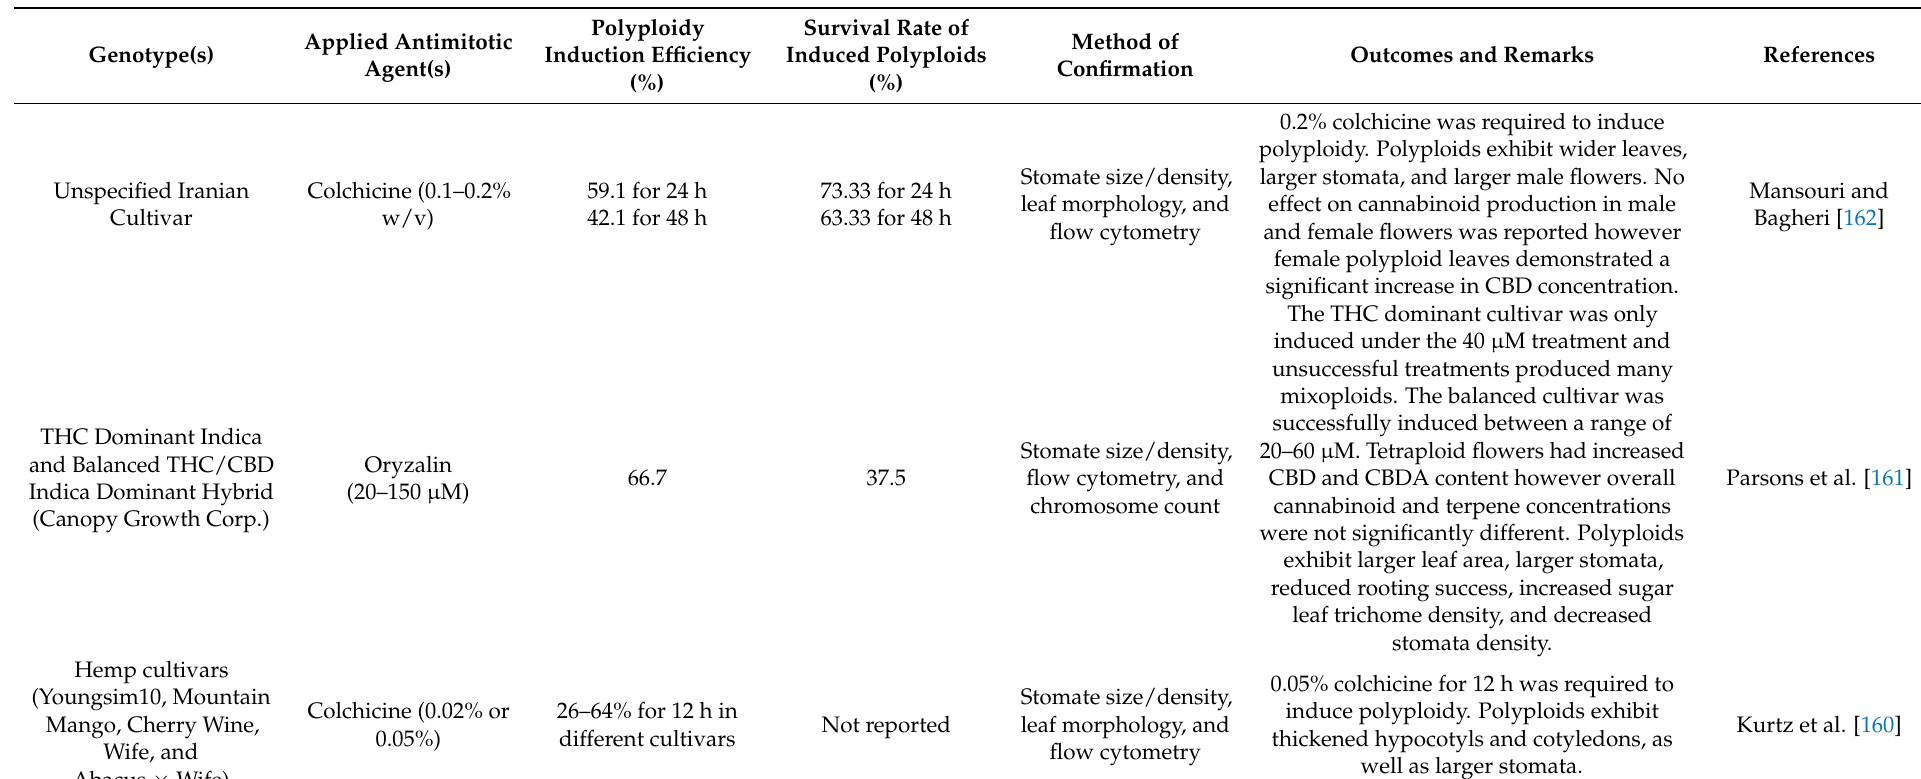
Table 4. Polyploidy induction studies in